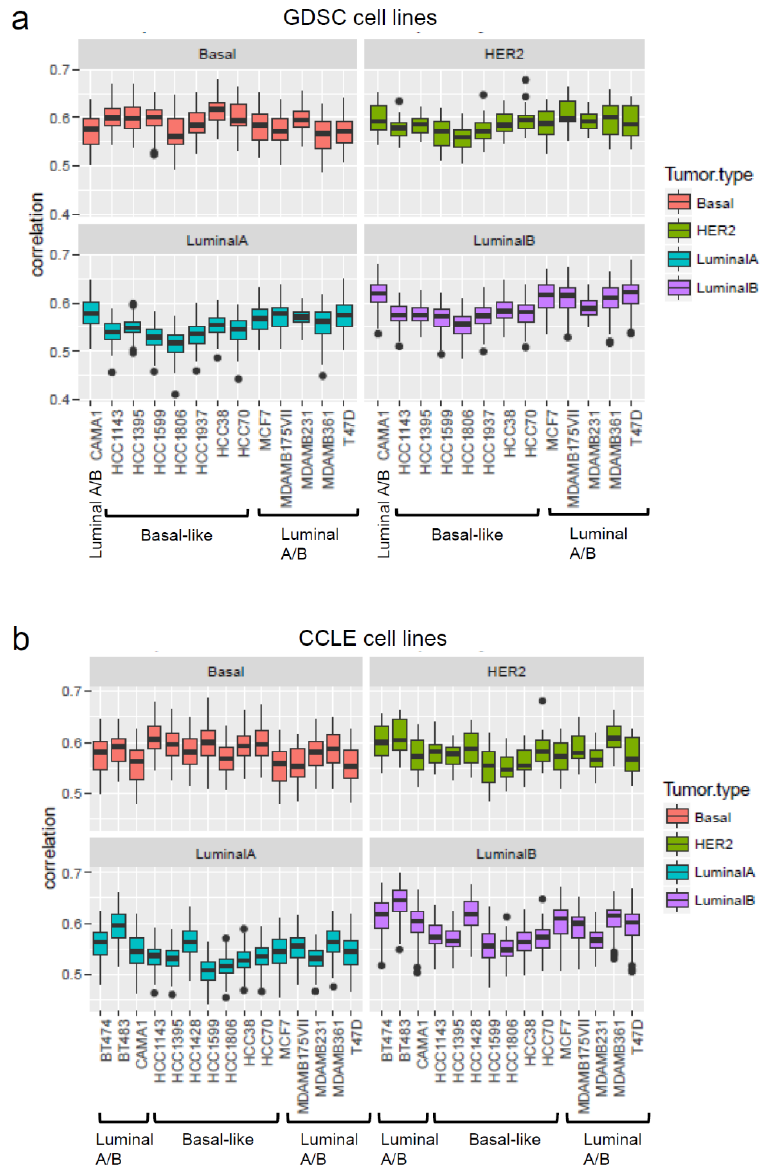
Figure 2. Correlation of gene expressions of commonly used breast cancer cell lines with primary breast tumours. The correlation of the gene expressions of GDSC and CCLE breast cancer cell lines were analysed with primary tumours from TGCA breast cancer analysis. ( a ) GDSC cell lines, ( b ) CCLE cell